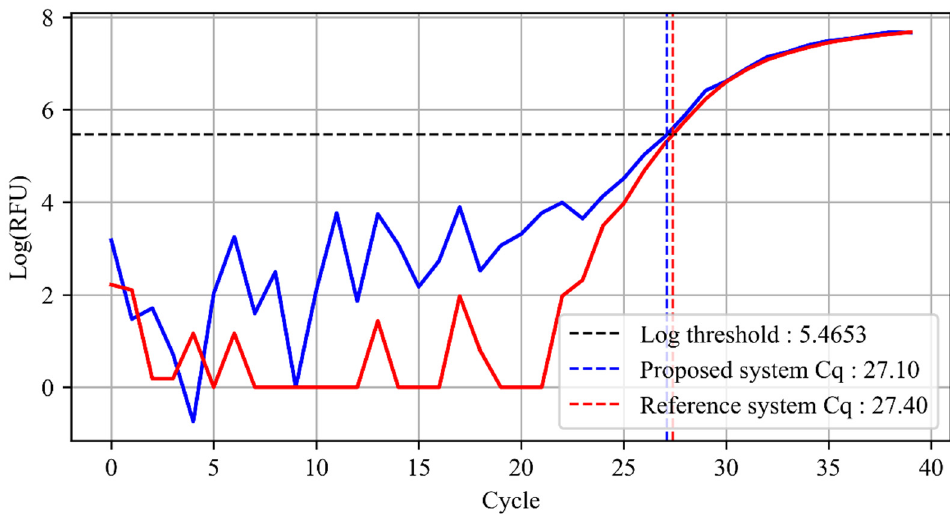
Figure 11. Cycle threshold obtained from the proposed system with a CMOS camera (blue) and reference system using a photodiode (red).